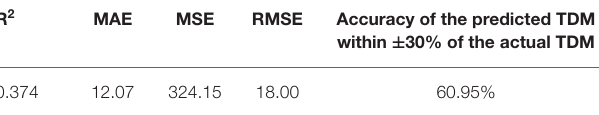
TABLE 5 | The prediction results in validation